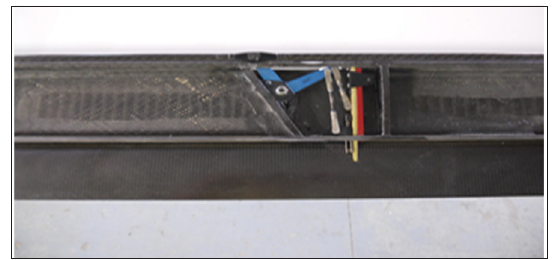
Fig. 13. The control mechanism with the miniflaps in the retracted position (Photo: P. Lauk)